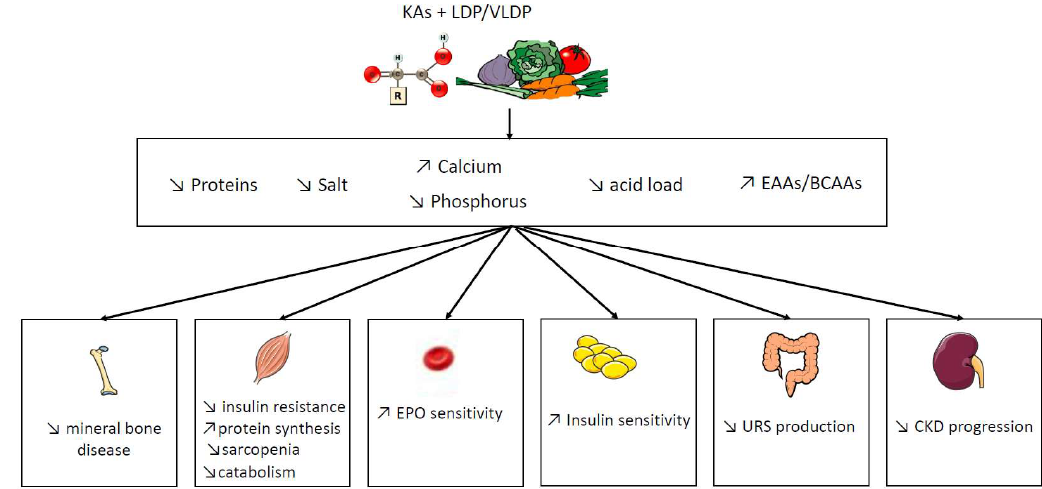
Figure 2. Proven and controversial mechanism of VLDP/LPD + KAs supplementation in CKD Abbreviations: URS: uremic retention solutes, EAAs: essential amino acids, BCAAs: branched-chain